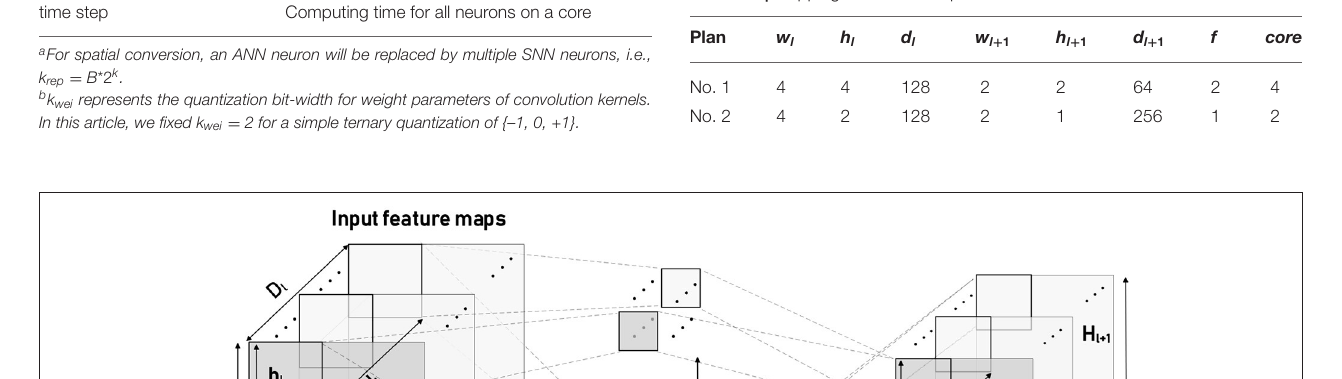
TABLE 2 | Mapping results of two plans.